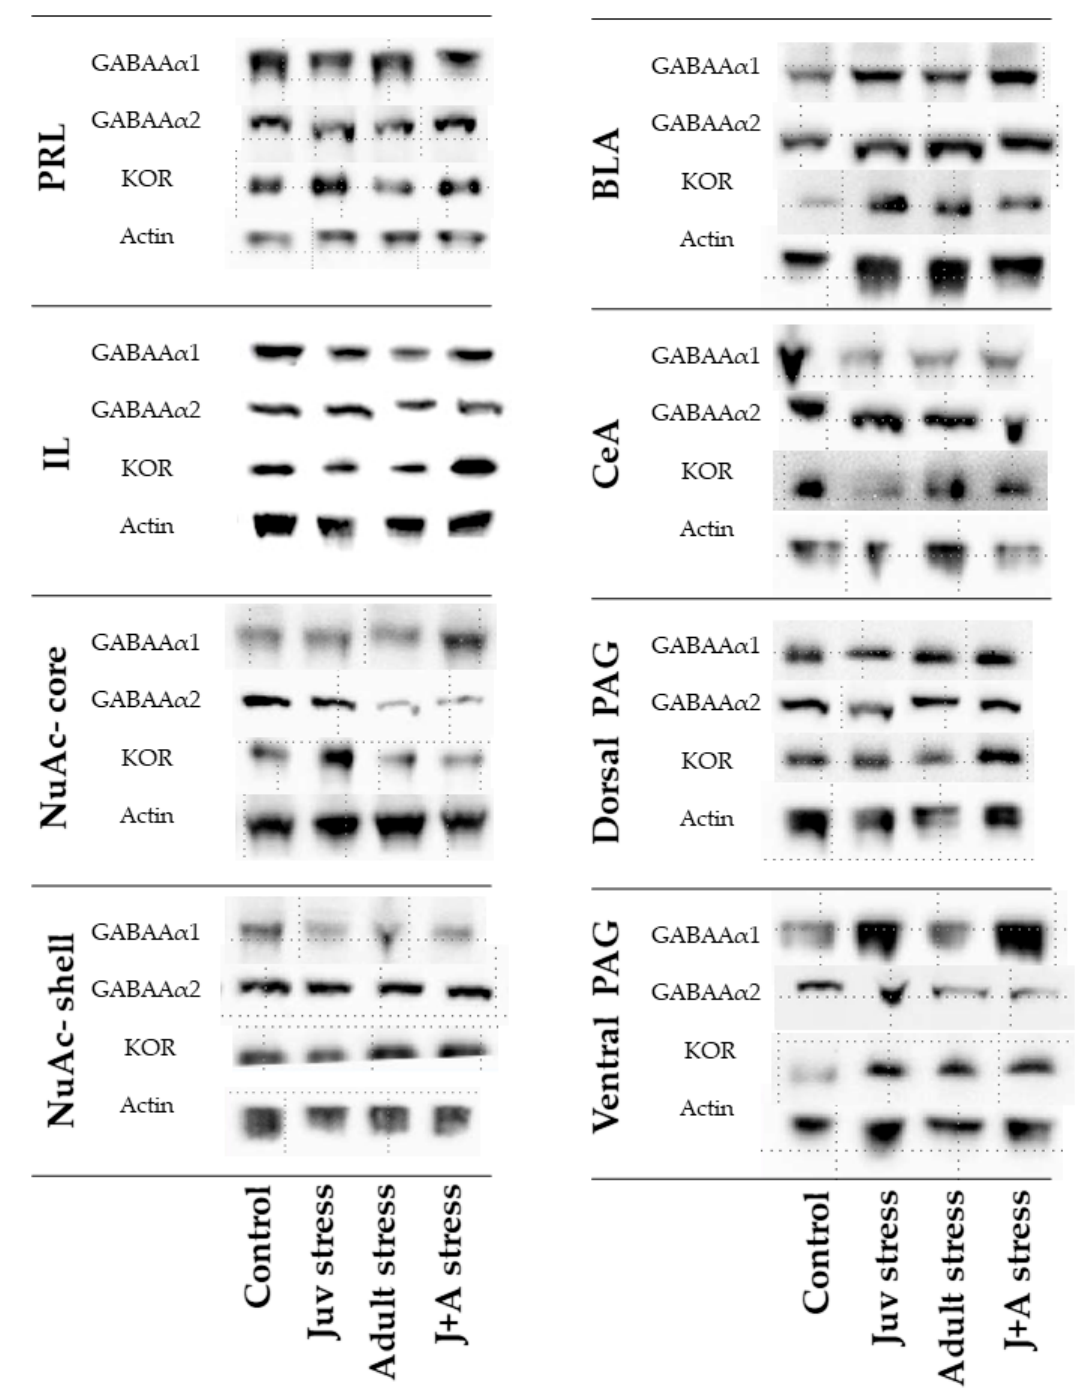
Figure A1. Representative blots of stress-related alterations in expression of GABAAR α 1 and α 2 subunits and KOR following juvenile stress, adulthood stress, or their combination: Sample blots are line blots from the same gel.